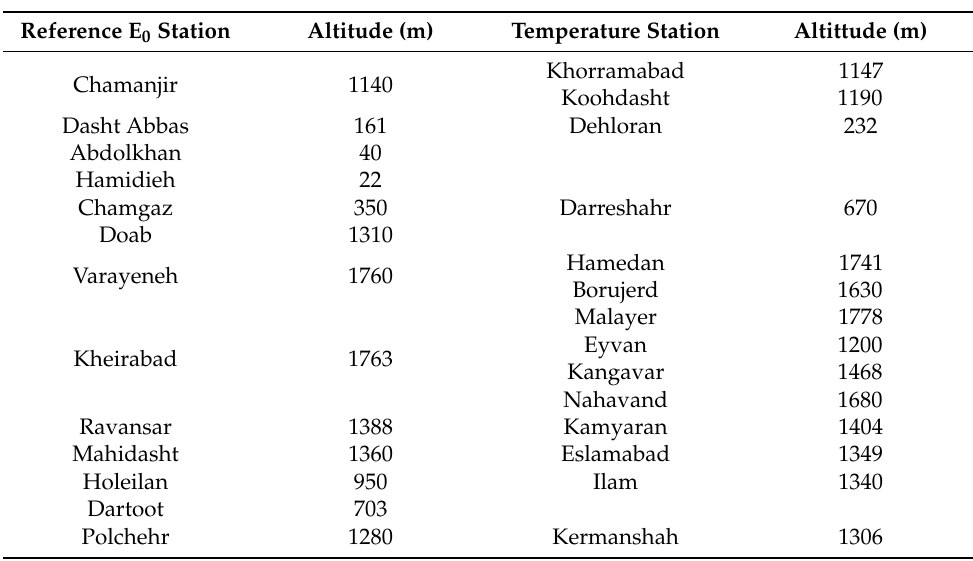
Table A2. E 0 reference stations and related temperature stations.